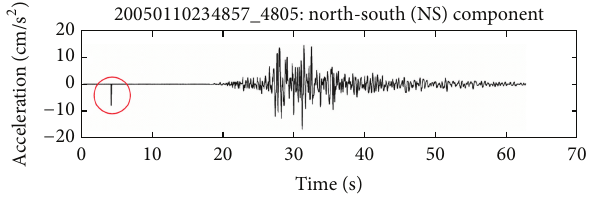
Figure 1: A “spike” in the beginning.